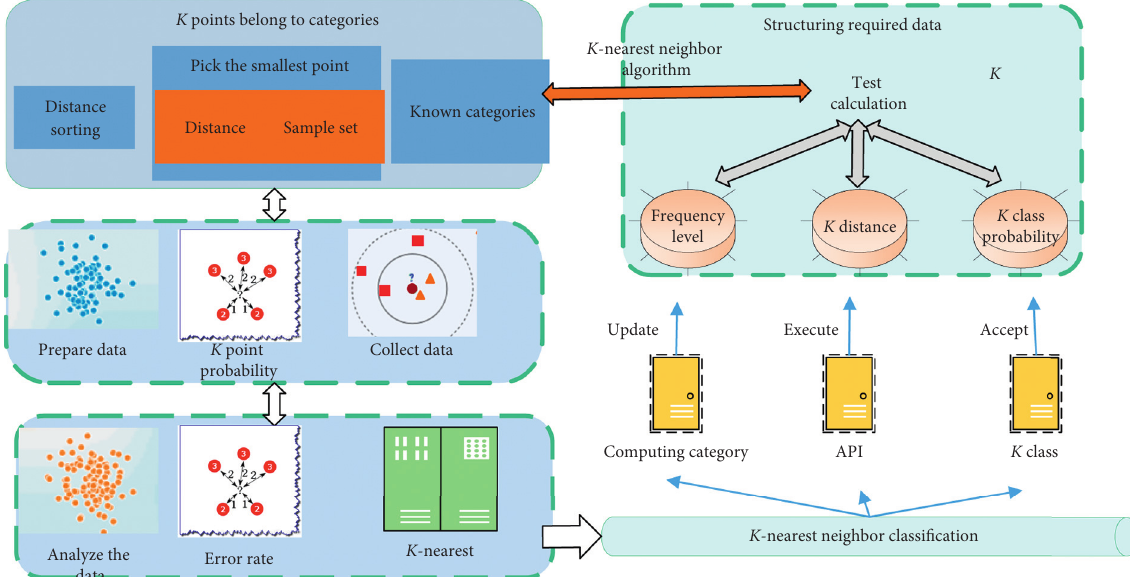
Figure 5: Operation flowchart of K -nearest neighbor